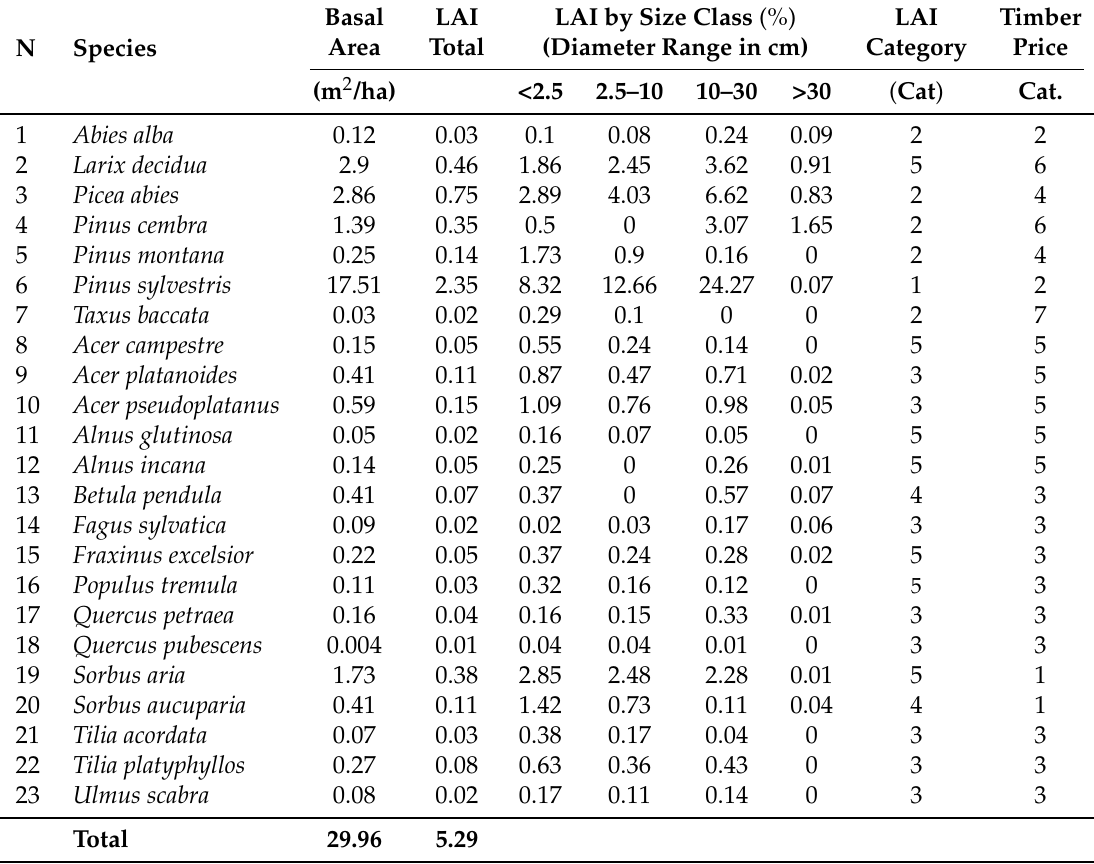
Table 1. Forest species distribution by size class, LAI parameter and timber price categories ( 1 )